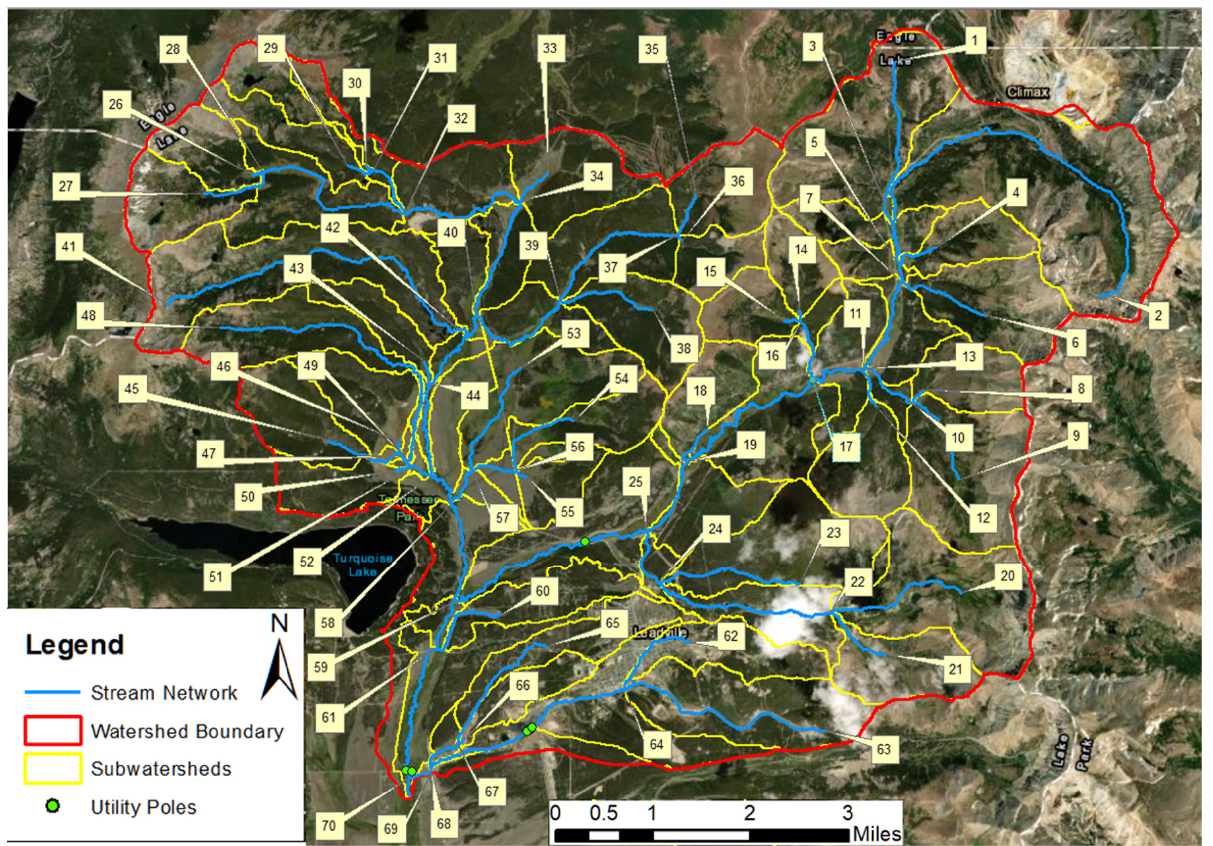
Figure 1. Whittier, NC watershed with labeled nodes shown in yellow square text boxes (35.399467°, − 83.292734°).